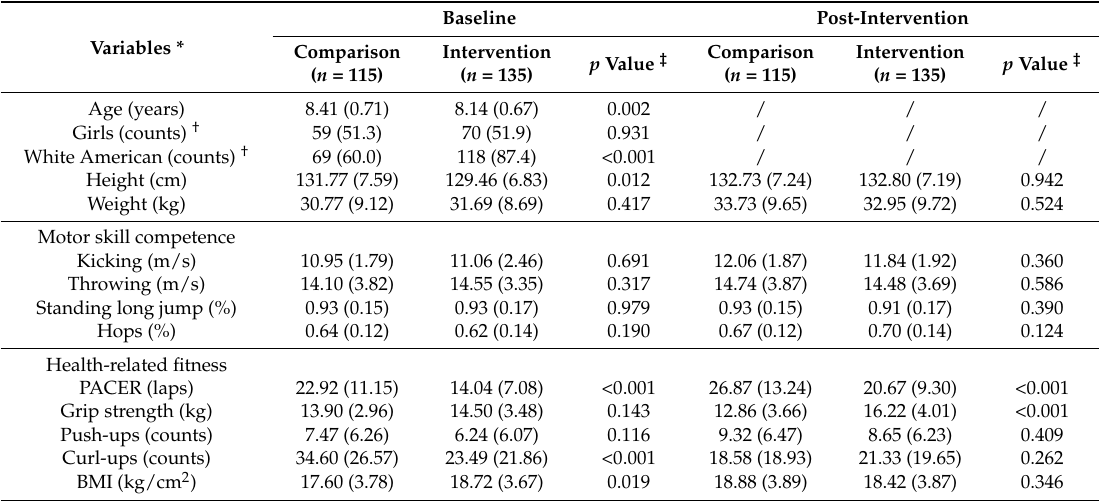
Table 1. Demographic characteristics of participants in baseline and post-intervention.